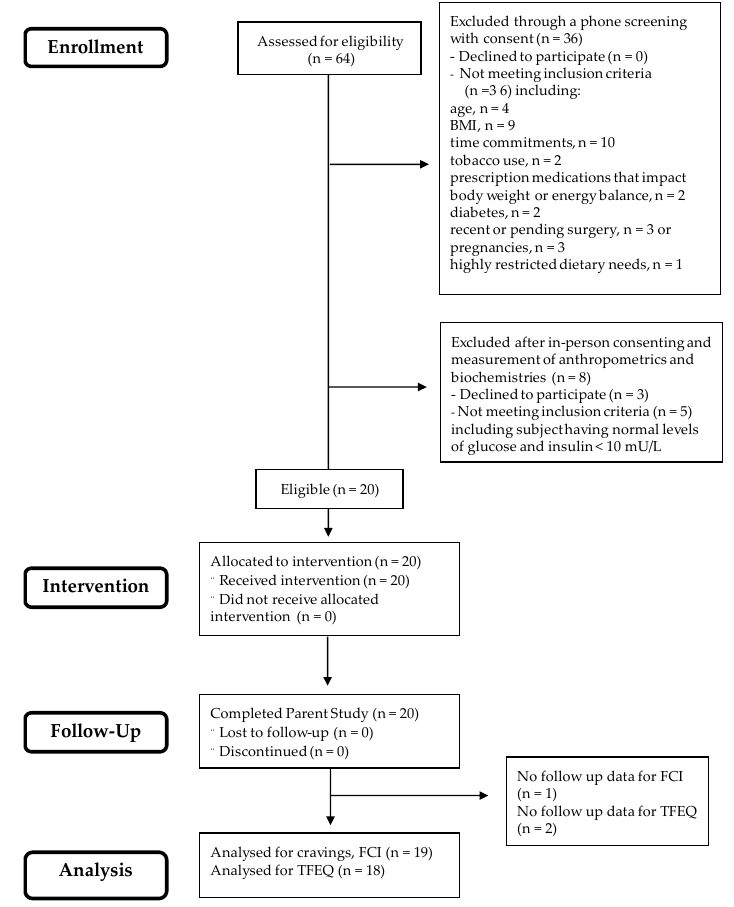
Figure 1. CONSORT diagram indicating the sample size at each stage of the study. This diagram is modified with permission from Syed-Majid et al. [30].